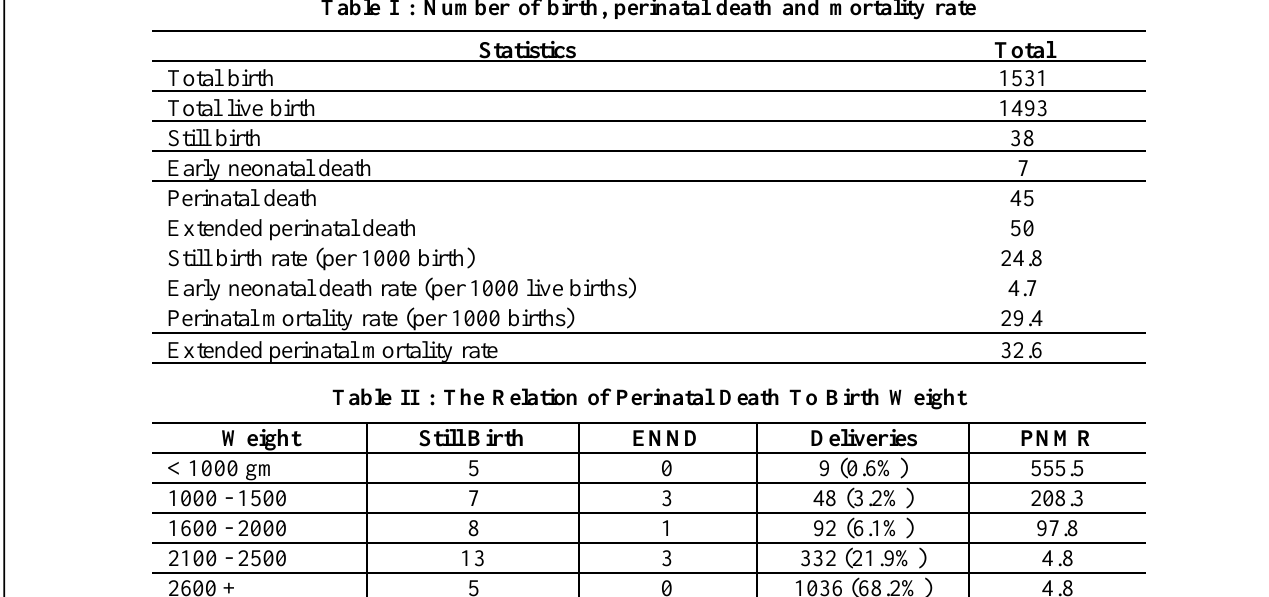
Table I : Number of birth, perinatal death and mortality rate Statistics